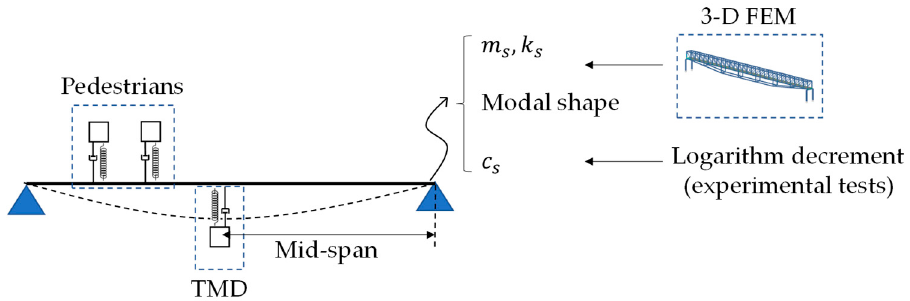
Figure 4. Schematic of the plane model used in the analyses.